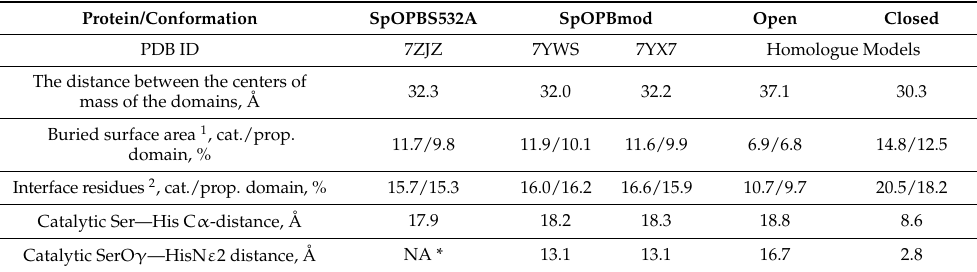
Table 2. Similar domain positioning and catalytic triad arrangements were observed in the SpOPB crystal structures obtained for enzymes with intact and modified hinge peptides. Protein/Conformation SpOPBS532A SpOPBmod Open Closed 7ZJZ 7YX7 Homologue